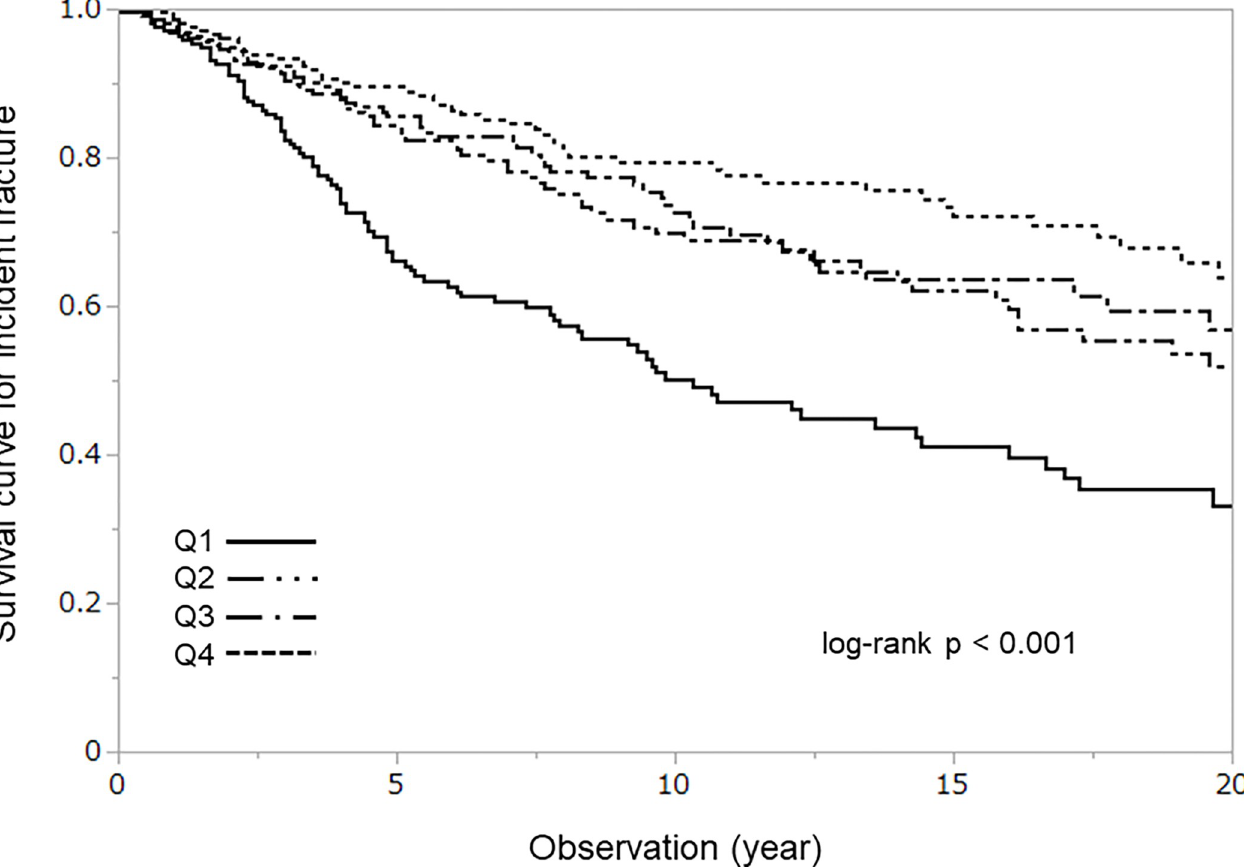
Fig 1. Time dependent fracture-free rates according to quartiles of the baseline NOx level. Subjects were divided into 4 groups according to the baseline serum level of NOx. The lowest group exhibited significantly higher and more rapid susceptibility to incident osteoporotic fracture than those in the other groups (p < 0.001 by log-rank